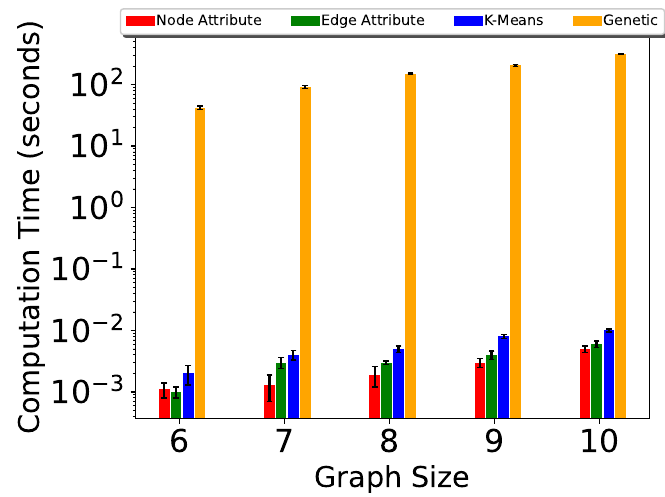
Figure 6. Computation time for P-TSP.